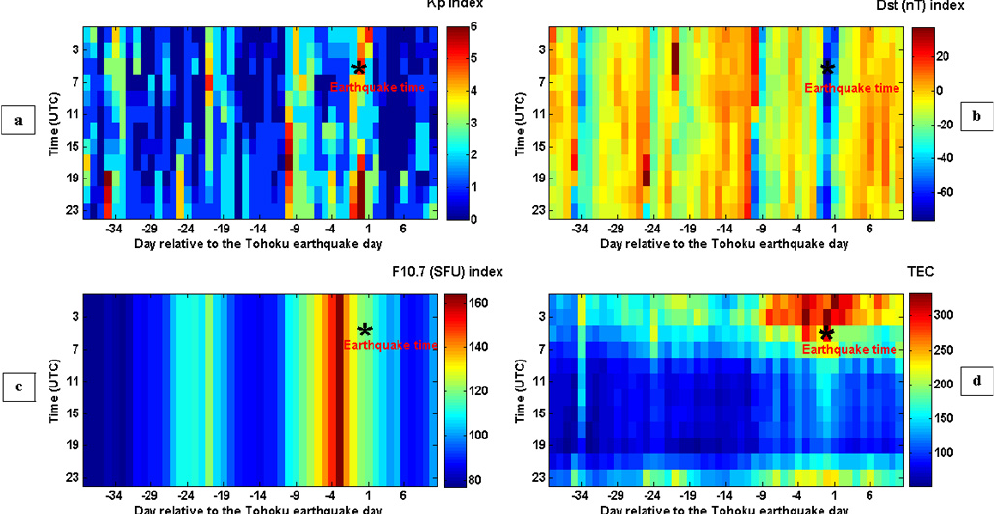
Fig. 1. (a) , (b) and (c) show, respectively, the variations of Kp, Dst and F10.7 geomagnetic and solar indices during the period of 1 February to 21 March 2011. (d) TEC variations. An asterisk indicates the earthquake time. The x-axis represents the days relative to the Tohoku earthquake day. The y-axis represents the universal time coordinate. Table 1. List of the earthquakes selected in this study (reported by http://earthquake.usgs.gov/). Area Date Time Geographic Magnitude Focal depth (UTC) latitude, longitude ( M w ) (km) Samoa Islands 29 September 2009 17:48:10.99 15.49 ◦ S, 172.10 ◦ W Haiti 12 January 2010 21:53:10